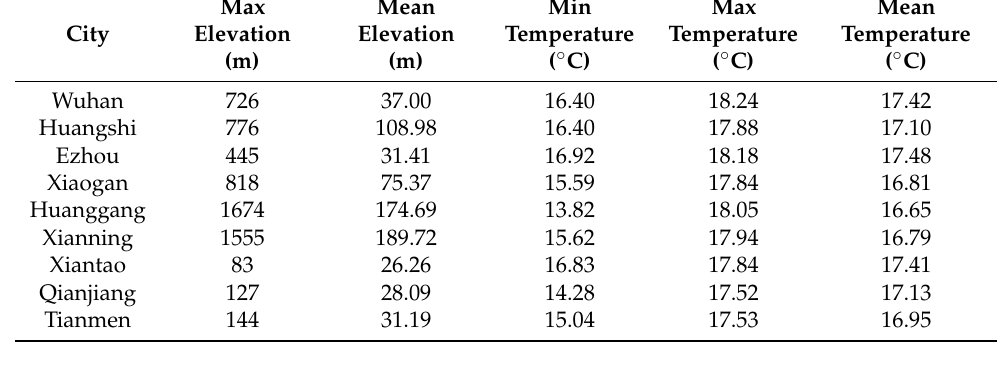
Table 3. Elevation and annual mean temperature statistics for WMA cities.